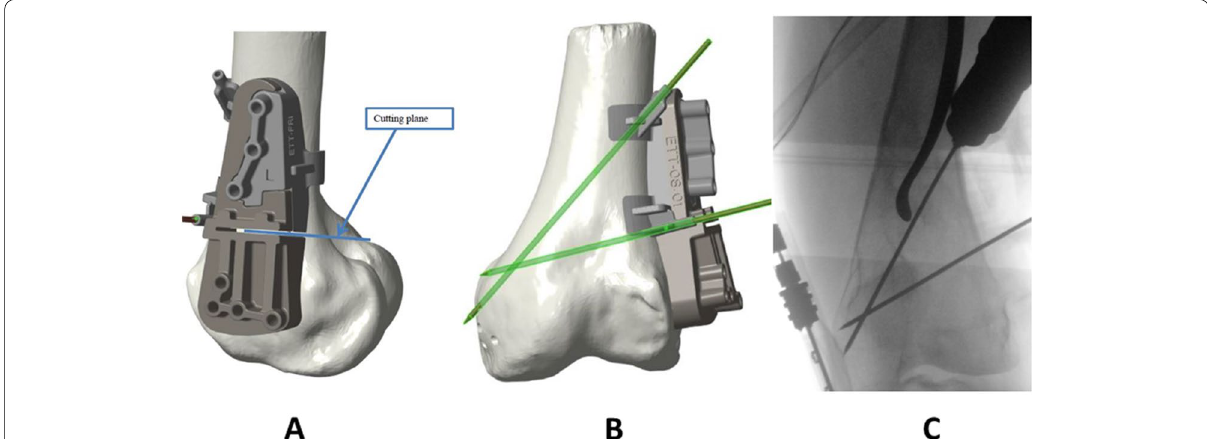
Fig. 2 Intraoperatively, the PSI guide was fixed with two K-wires ( A the PSI